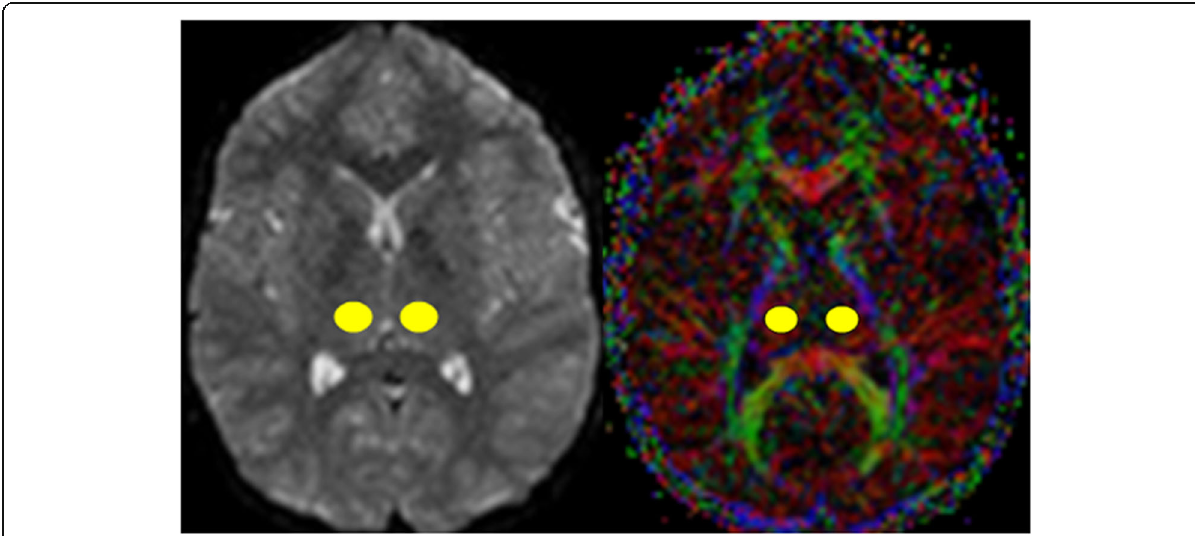
Fig. 2 Axial b0 image (left) and FA map (right) showing ROI placed within both thalami to calculate ADC and FA values